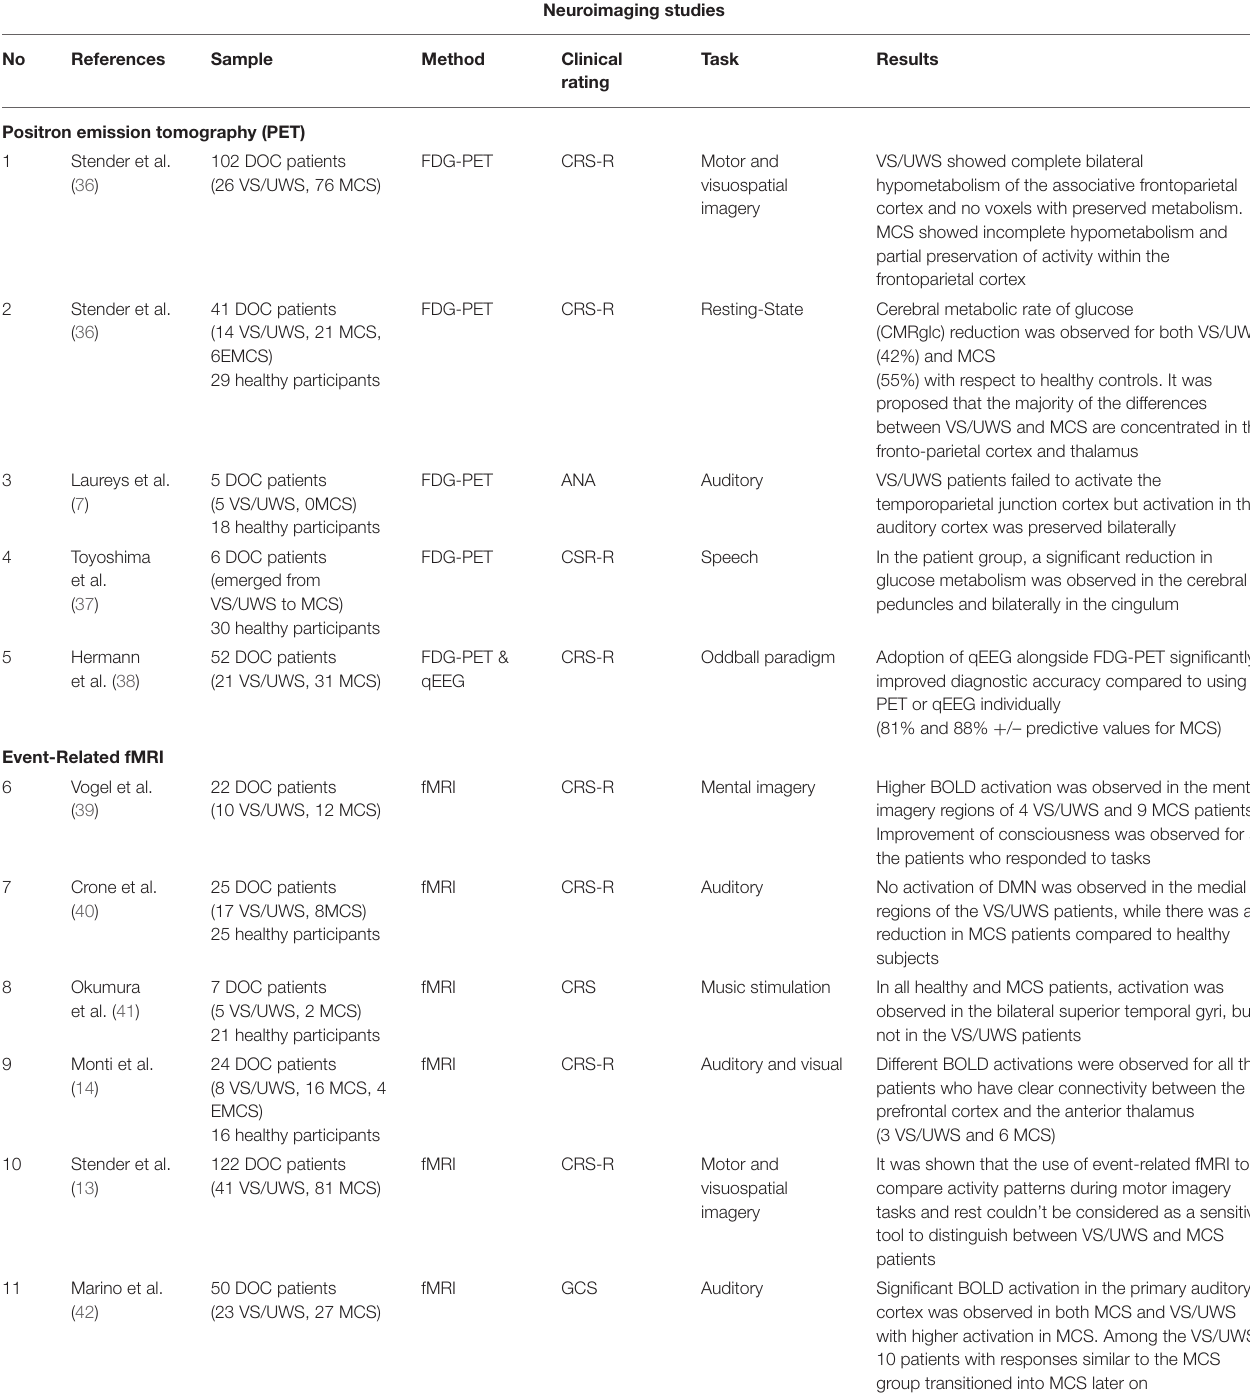
TABLE 2 | Studies reviewed and included in this